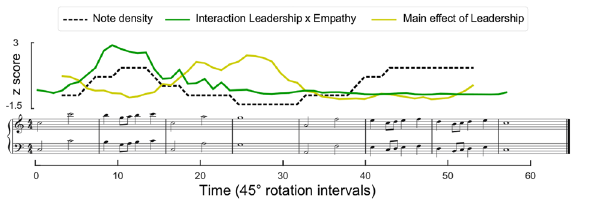
Figure 3. Relationship of musical note density to interpersonal synchrony and tempo stability. Estimated note density (dashed line) is plotted as a function of the musical score, with higher values representing higher density of notes within windows comprising 4 beats. The interaction between EMPATHY and LEADERSHIP associated with interpersonal synchrony (green line, Fig. 2) was stronger when note density was higher. However, the main effect of LEADERSHIP associated with individual tempo stability (yellow line, Fig. 2) was stronger when note density was lower. Statistics are reported in the results section. All timeseries were transformed into